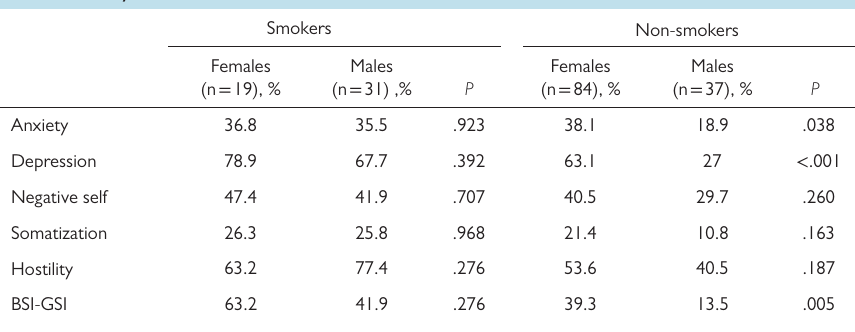
Table 3. The Rate of BSI Scores at Psychopathological Levels in Smoking and Non-smoking Adolescents by Gender